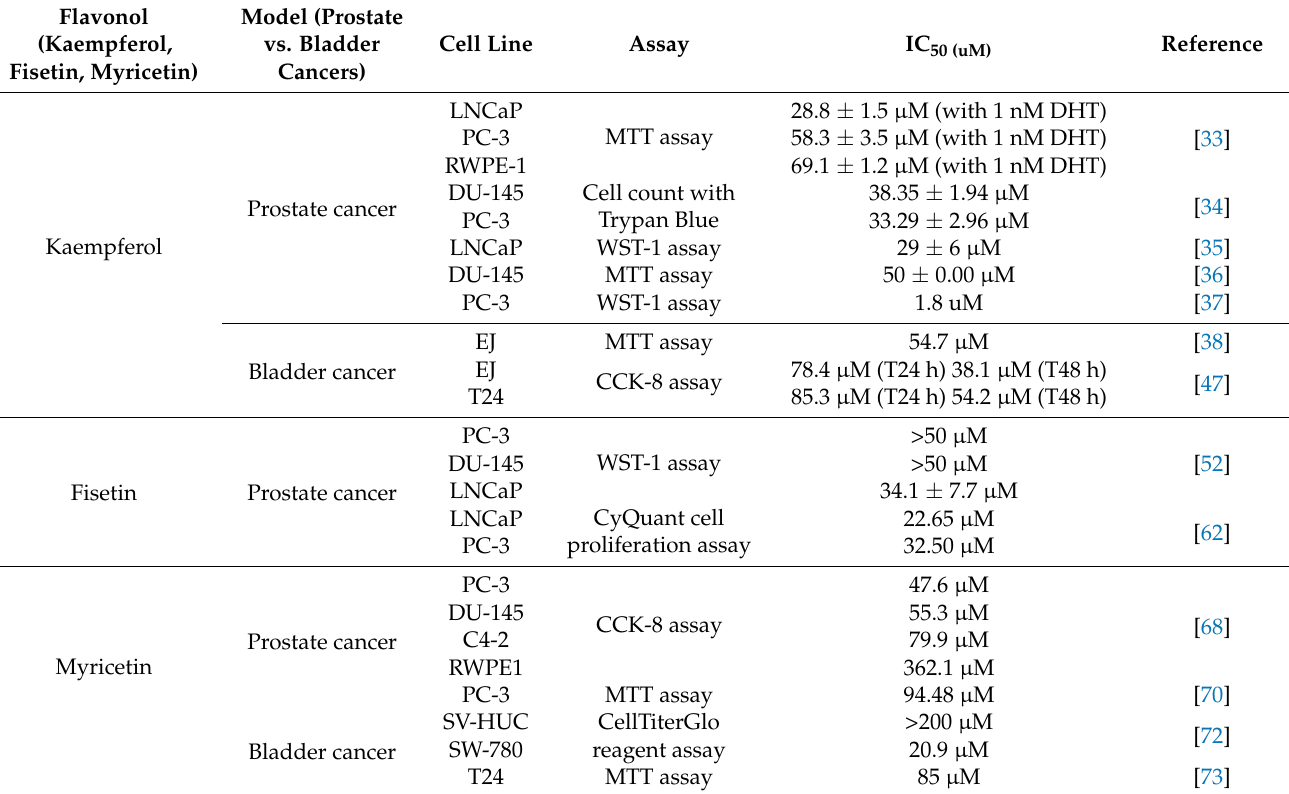
Table 2. Results of in vitro models with available IC 50